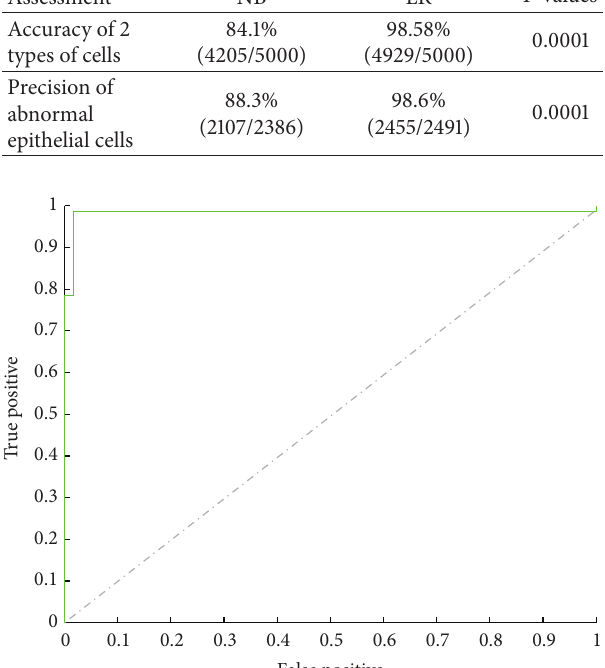
Figure 6: The ROC curves of the results of Step 2 classification. 𝑥 - axis is the false positive. 𝑦 -axis is true positive. The dash and dot line indicate the chance curve. The ROC curve of the results from Step 2 classification is in green color and on the left upper corner.